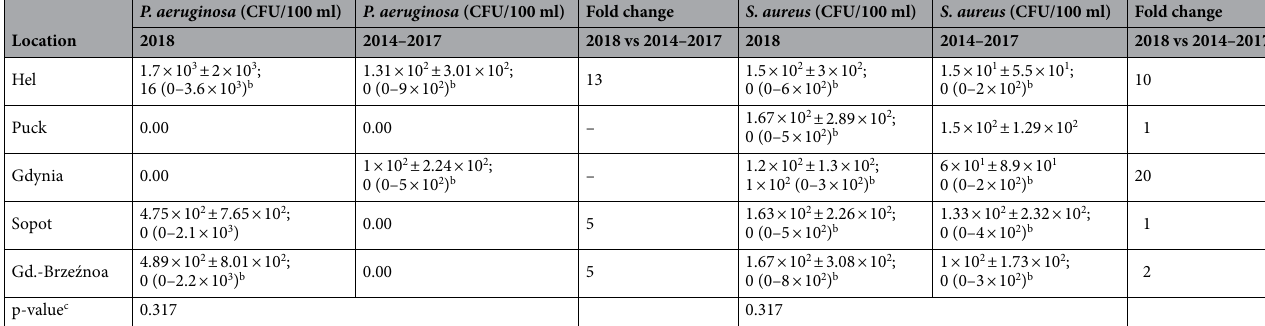
Table 3. The mean and standard deviation of concentration of P. aeruginosa and S. aureus (CFU/100 ml) in sea-surface microlayer water collected from the Bay of Gdansk in 2018 versus 2014-–2017. a Gd.-Brzeźno—it is an abbreviation of the town name Gdańsk-Brzeźno, b in case of a higher standard deviation than the mean, the median and range (min–max) was calculated, c Friedman test,